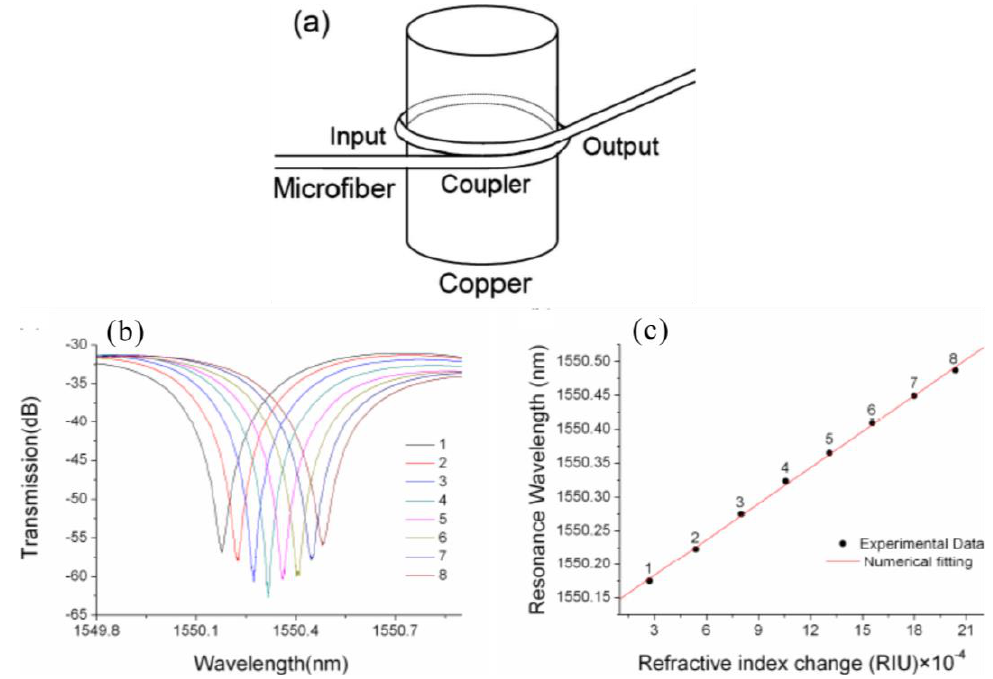
Figure 7. ( a ) Schematic side view of a copper rod supported microfiber loop [133]; ( b ) Spectral shifts of a resonant peak caused by index change of the solution; and ( c ) resonant wavelength as a function of the RI change [134].